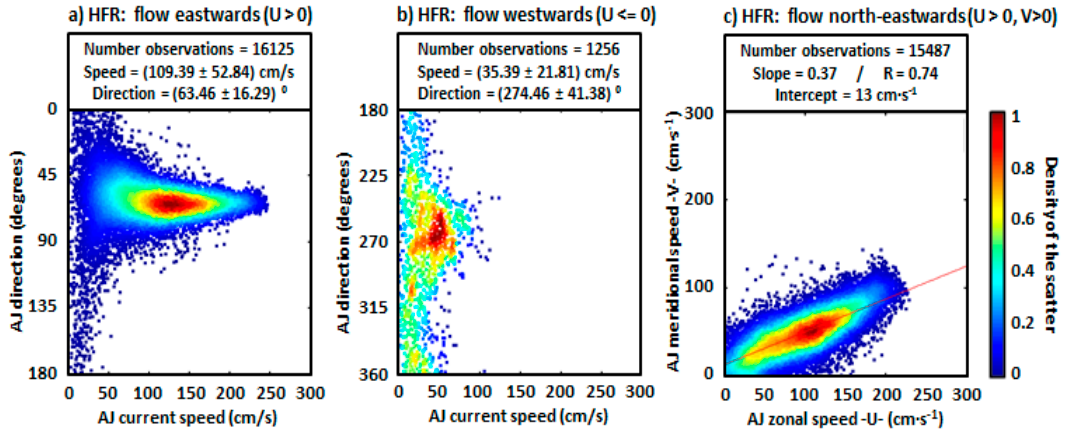
Figure 3. 2-year scatter plot of hourly Atlantic Jet (AJ) current direction (angle measured clockwise from the North) versus speed estimations at the midpoint of the selected transect: ( a ) AJ flowing eastwards (positive zonal speed, U > 0); ( b ) AJ flowing westwards (U < 0). Mean and standard deviation values of both AJ speed and direction computed for 2016–2017; ( c ) Scatter plot of meridional versus zonal current speed when the AJ flows north-eastwards. Results of the best linear fit are provided, where R is the correlation coefficient.